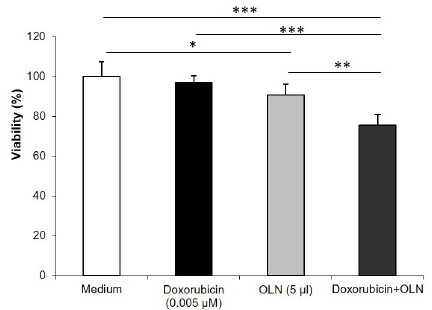
Figure 4. DOX in OLND promotes synergistic antitumor effects. Cell viability was evaluated by MTT assay. Data are expressed as percentage vs. control. TUBO cells were left untreated or incubated for 48 h with DOX (0.005 μM), OLNDs (2.5% v / v ) or DOX-loaded OLNDs (0.005 μM/2.5% v / v ). Results are shown as means ± SD from three independent experiments. Significance of the differences: * p < 0.05; ** p < 0.005; *** p < 0.001.